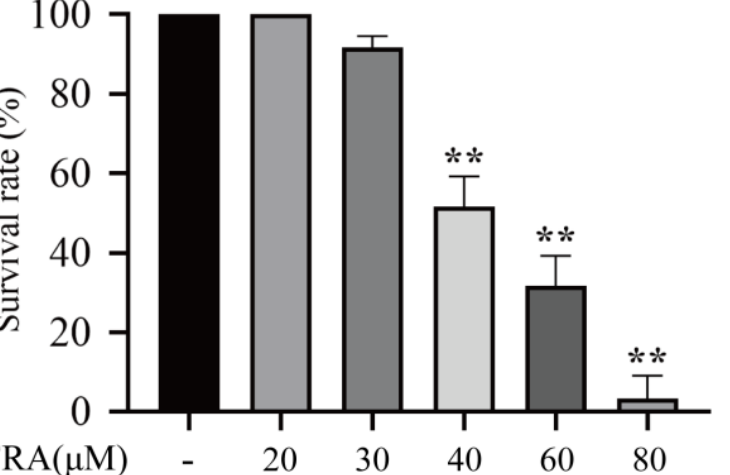
Figure 1. Survival rate of zebrafish larvae exposed to FRA for 48 h. Data are presented as the mean ± SD. Each experiment was performed 3 times with 30 randomly selected zebrafish larvae. ** p < 0.01 vs. control.